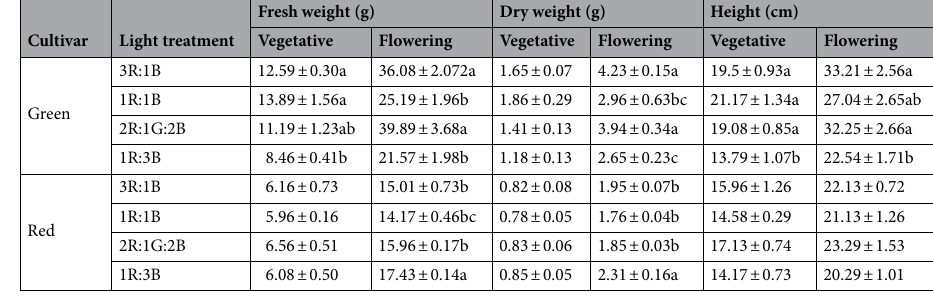
Table 1. Biomass and plant height of green and red holy basil at vegetative stage (35 DAT) and flowering stage (42 DAT) under different light spectrum ratios (3R:1B, 1R:1B, 2R:1G:2B, and 1R:3B). R, G and B represent the red, green and blue llight spectra, respectively, and number before the letters stand for the ratio of each lighrt spectra . Lower-case letters after the same parameter indicate significant differences (p < 0.05). Values are represented as mean ± SE (n = 4). ANOVA was performed followed by mean comparison with